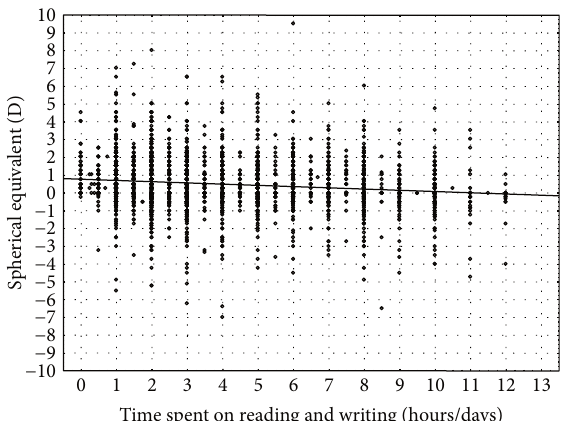
Figure 1: Mean spherical equivalent in relation to reading and writing.